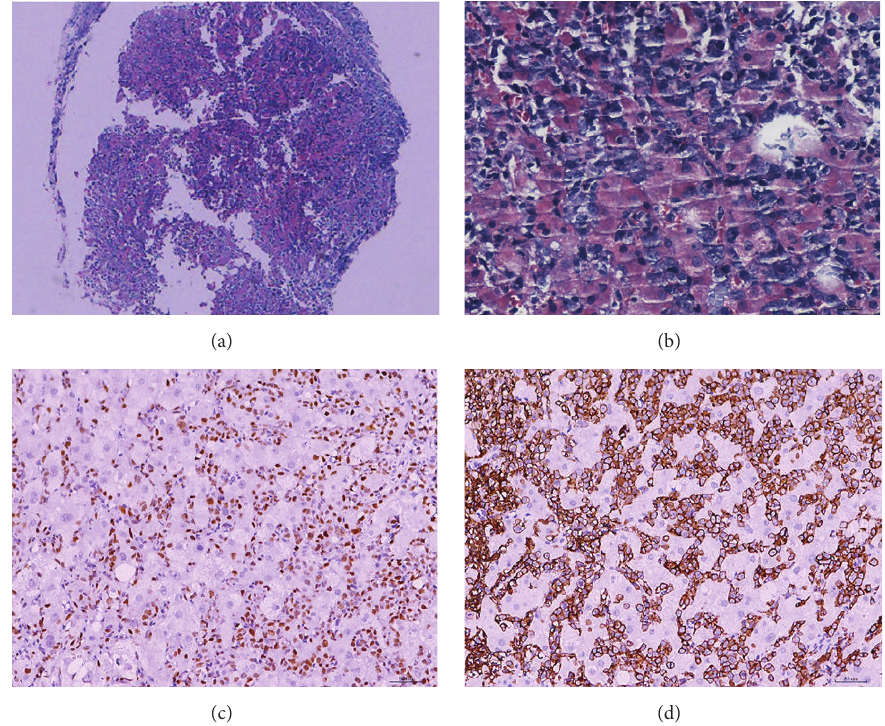
Figure 3: Liver biopsy pathology and histochemistry (hematoxylin-eosin staining,). (a) and (b) Heteromorphic lymphocytes were observed in the hepatic sinusoid and portal area. The nuclei were round or oval. The cells presented with one or multiple nucleoli. The nuclear mitotic figure was common, low, and high magnifications ( × 4, × 40, resp.). (c) BCL-6 was diffusely strongly positive. (d) CD20 was diffusely strongly